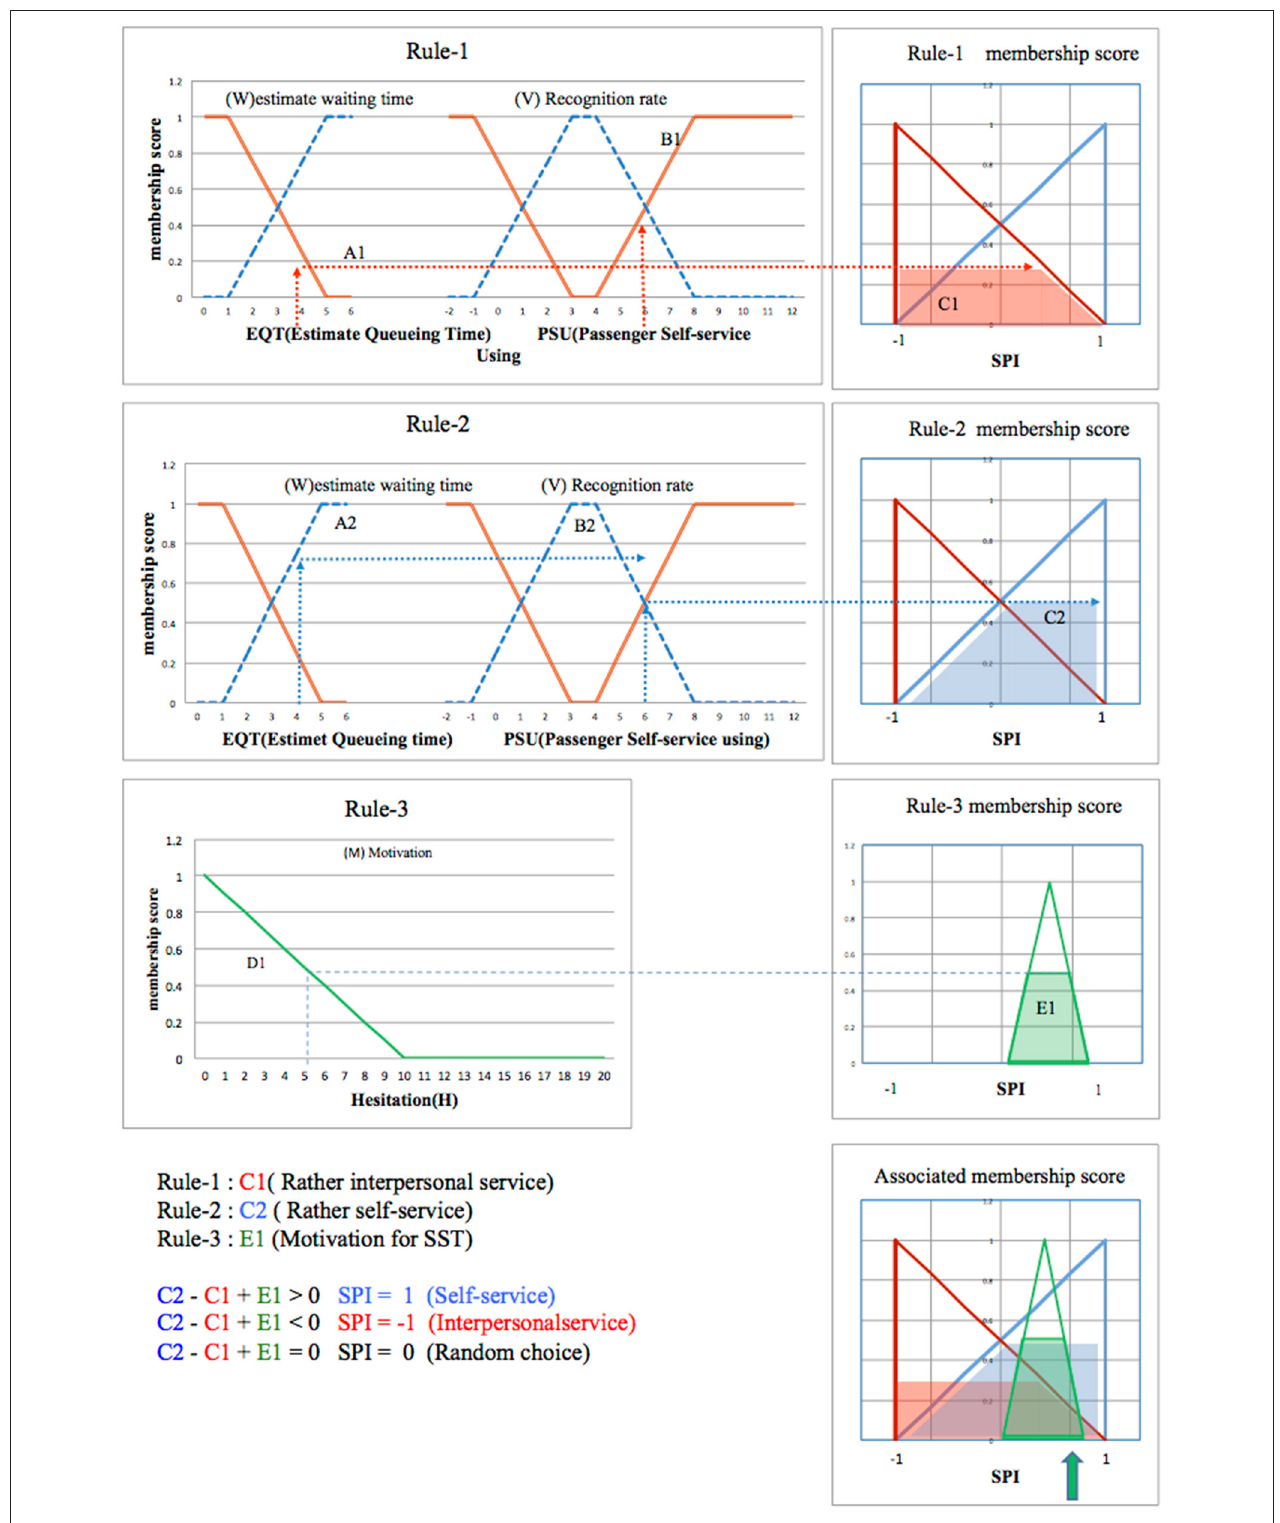
FIGURE 3 | Fuzzy membership